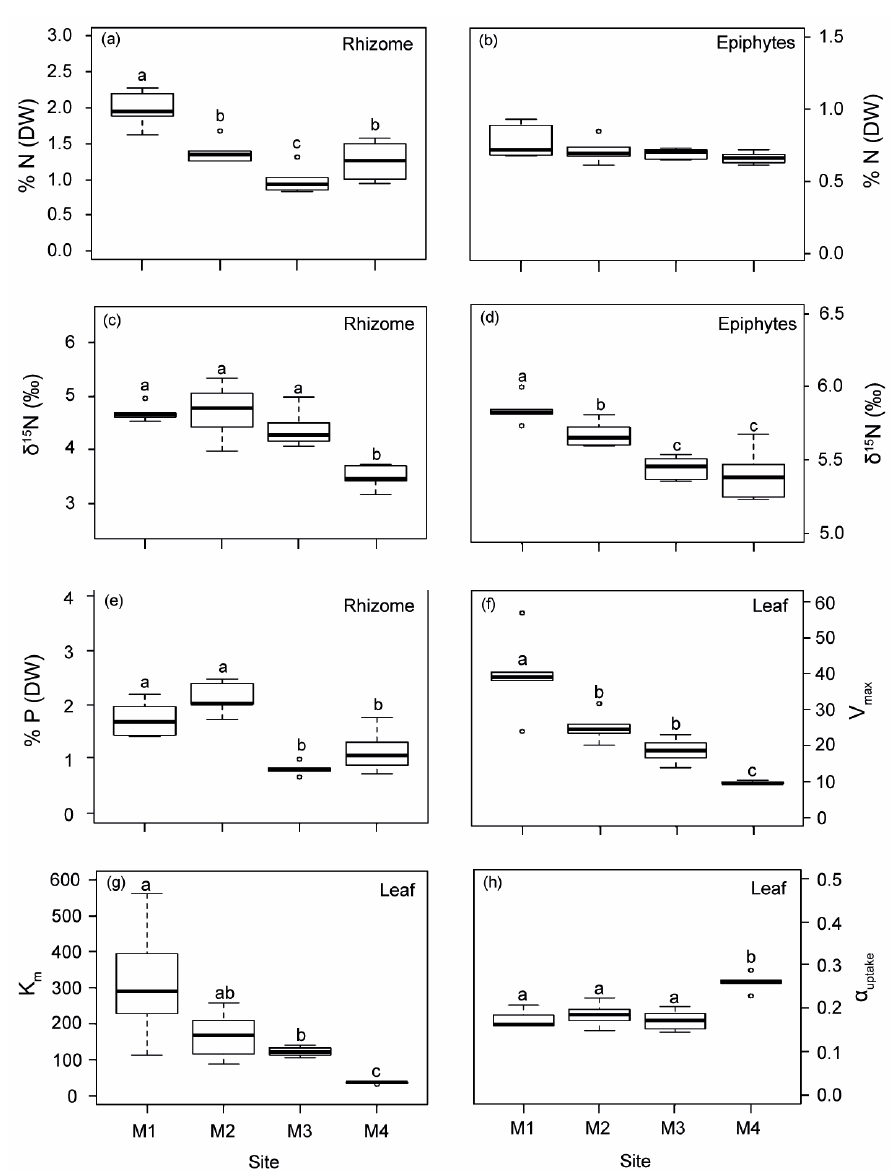
Figure 1. Biological indicators of nutrient loads (rhizome and epiphytes) and leaf ammonium uptake kinetic parameters measured in P. oceanica from the four sampling deep meadow sites (M1–M4) in autumn. ( a , b ) Nitrogen content (% N), ( c , d ) N isotopic signature ( δ 15 N), ( e ) phosphorous content (% P), ( f ) maximum uptake rates (V max ), ( g ) half-saturation constant (K m ) and ( h ) uptake efficiency ( α uptake ). Different letters denote significant differences among sites (Tukey test, p < 0.05).